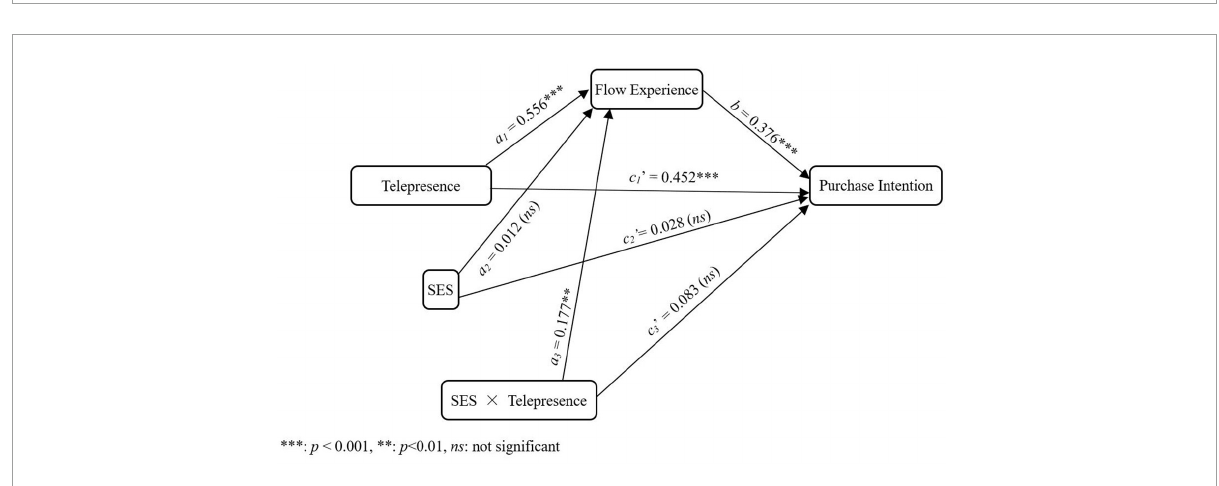
FIGURE3 The moderated mediation model underlying the effect of telepresence on purchase